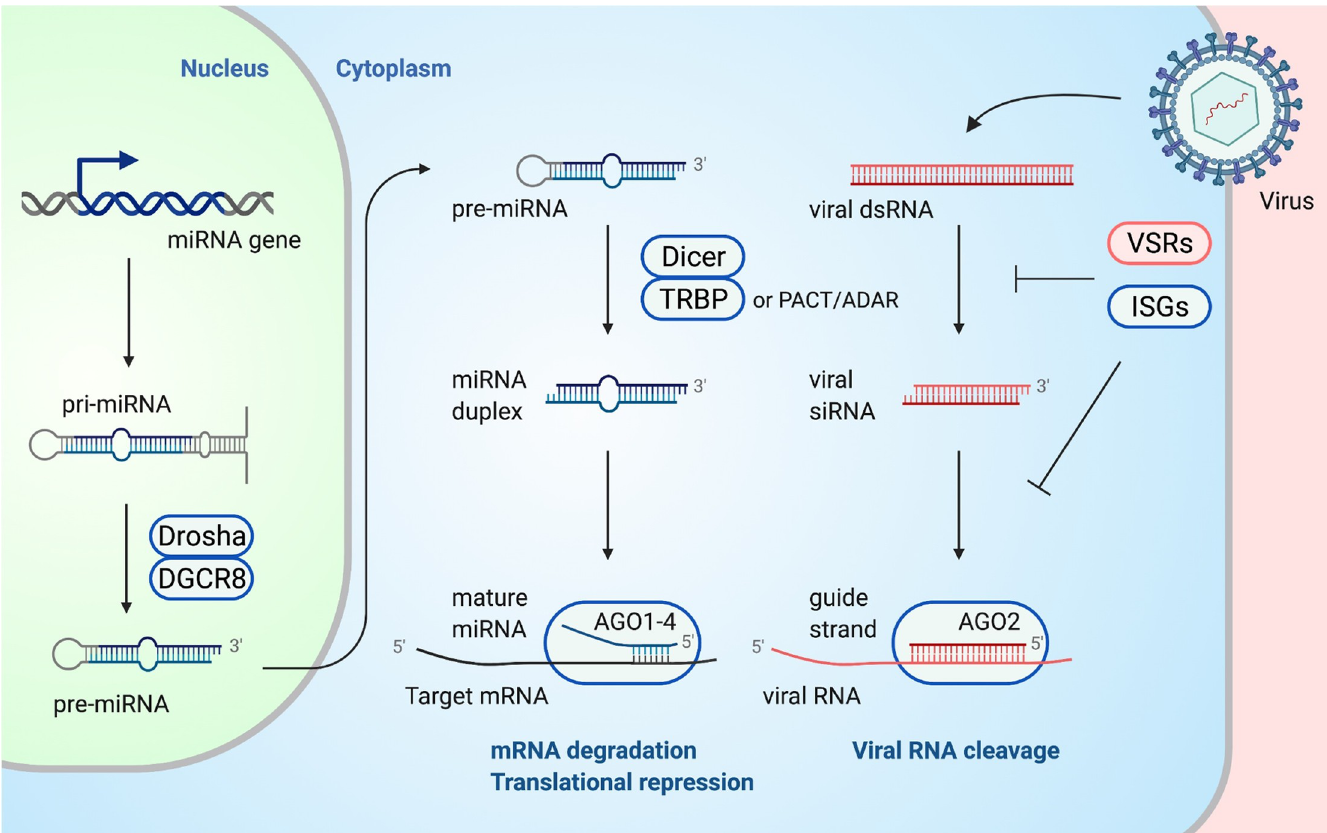
Fig 1. Overview of antiviral siRNA/miRNA pathways and inhibitory factors. Endogenous miRNAs are transcribed from the genome as pri-miRNAs and are processed into pre-miRNAs by the Drosha/DGCR8 complex. Pre-miRNAs are exported to the cytoplasm and are processed into miRNA duplexes by Dicer and its partner protein complex. Viral RNAs are capable of being processed by the same ribonucleases; however, some VSRs or ISGs are reported to inhibit the processing of small RNAs in mammalian cells. Mature miRNAs or siRNAs silence both endogenous and exogenous RNAs loaded on AGO proteins in collaboration with various RNA silencing regulators for the antiviral functions. Endogenous nucleic acids and proteins: blue; viral nucleic acids and proteins: red. AGO, argonaute; dsRNA, double-stranded RNA; ISG, IFN-stimulated gene; miRNA, microRNA; pre-miRNA, precursor miRNA; pri-miRNA, primary transcript; siRNA, small interfering RNA; VSR, viral suppressor of